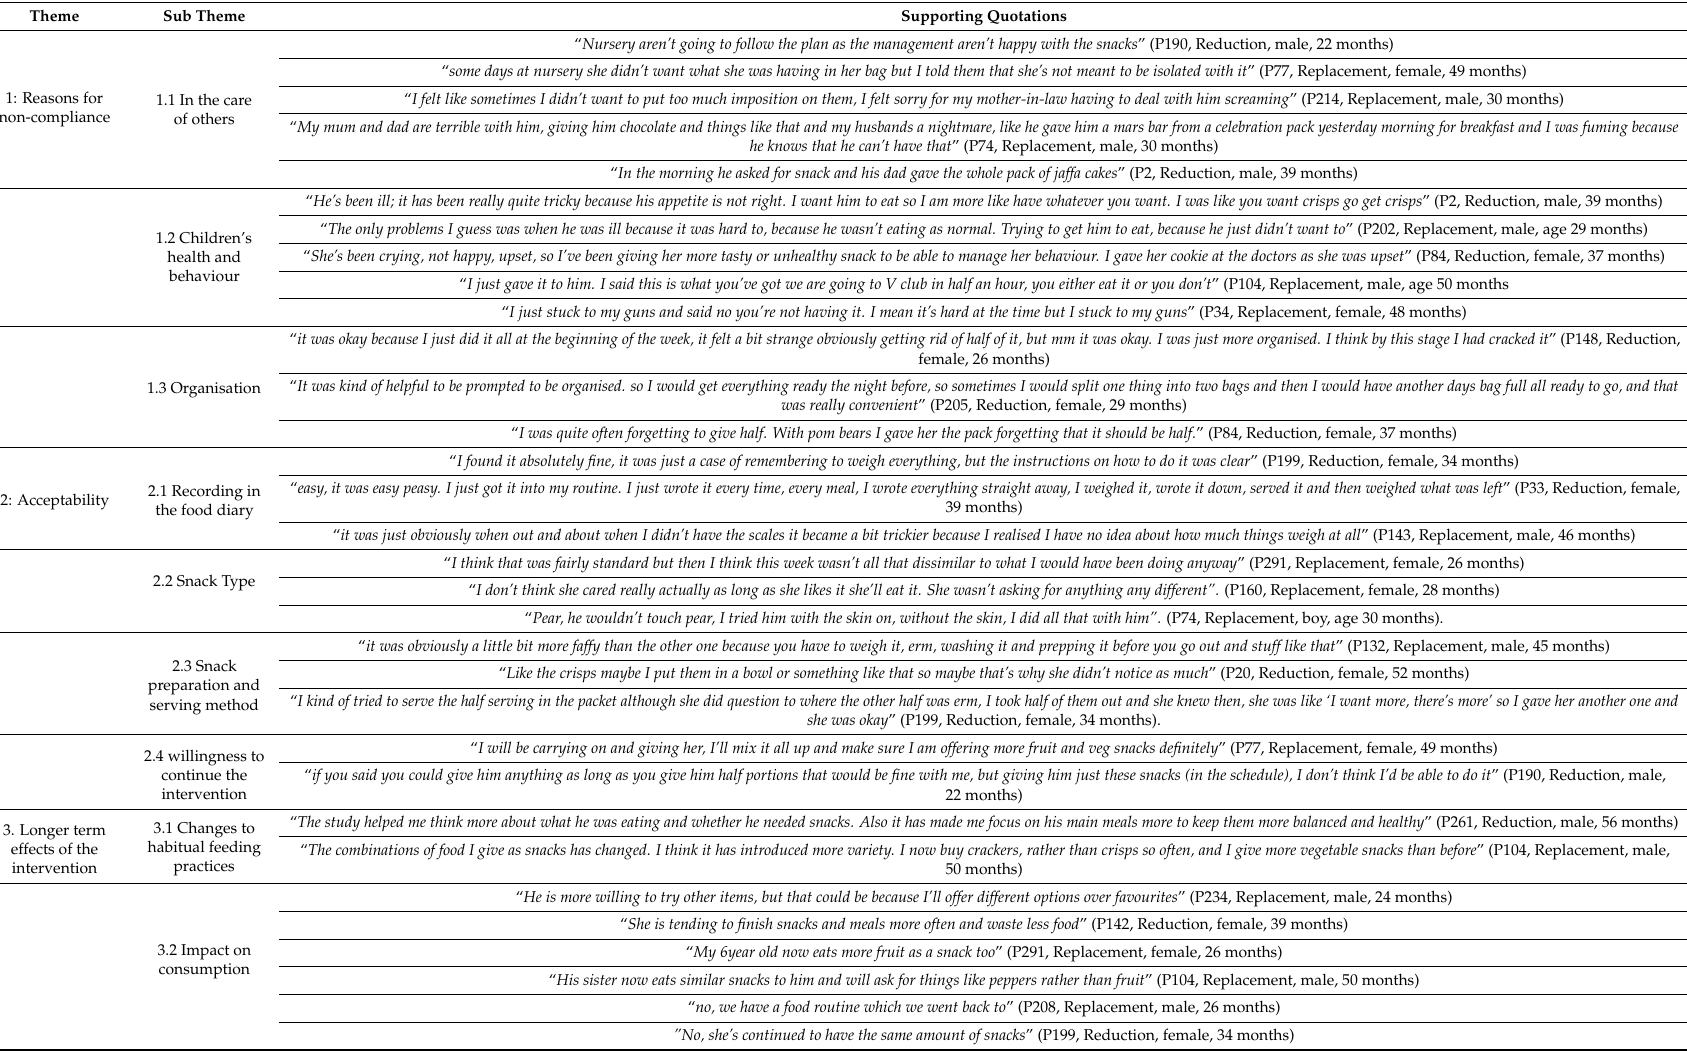
Table A2. Quotations supporting the themes constructed from interviews with mothers about their experiences taking part in the intervention. Theme Sub Theme Supporting